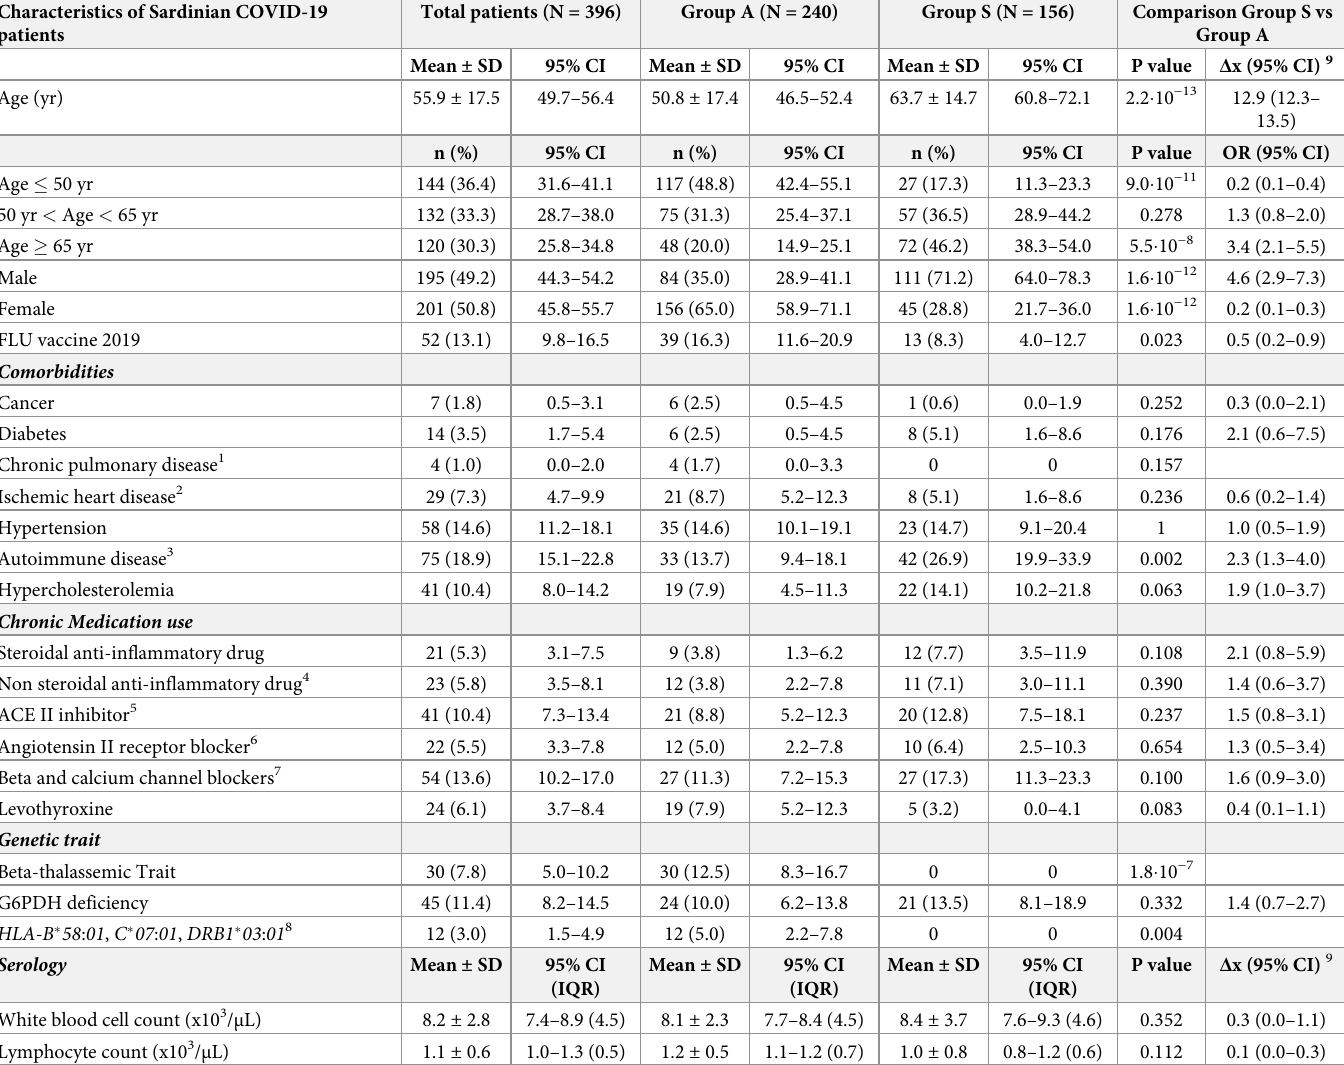
Table 1. Comparisons of baseline clinical, genetic and biochemical parameters between COVID-19 patients with severe disease (Group S) and a-paucisymptomatic patients (Group A). Characteristics of Sardinian COVID-19